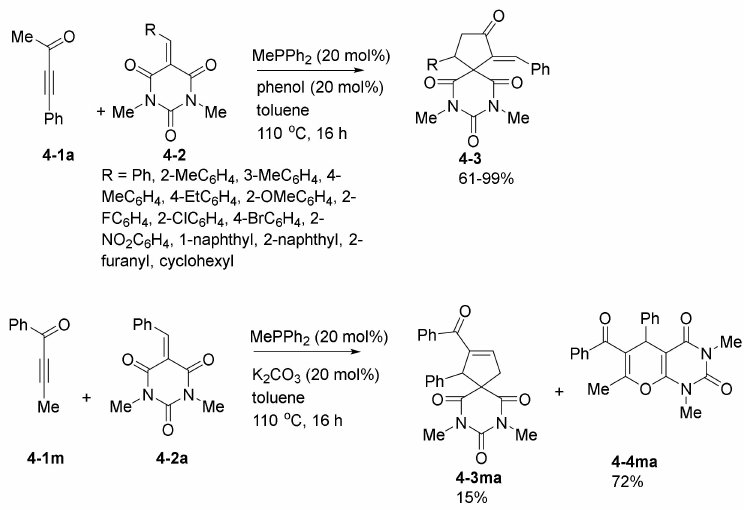
Scheme 7. Proposed mechanism for the intermolecular annulation